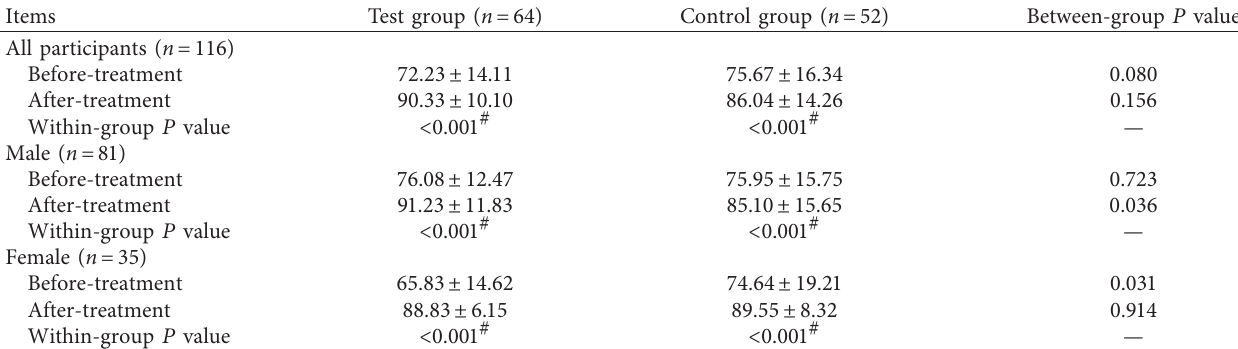
Table 4: Changes in Lysholm scores in both groups ( N � 116).